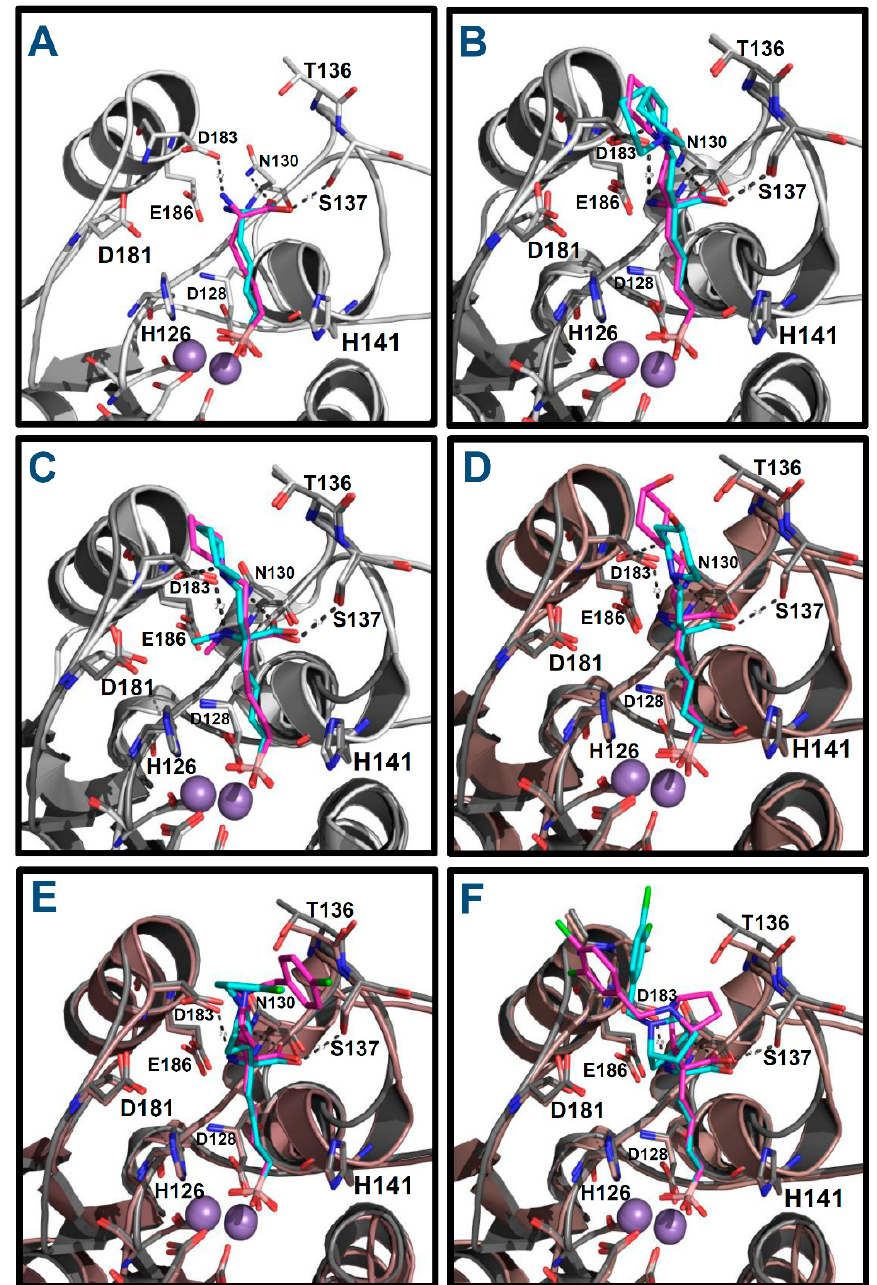
Figure 4. Alignment of docked structures on hARGI–inhibitor X-ray reference structures: ( A ) ABH